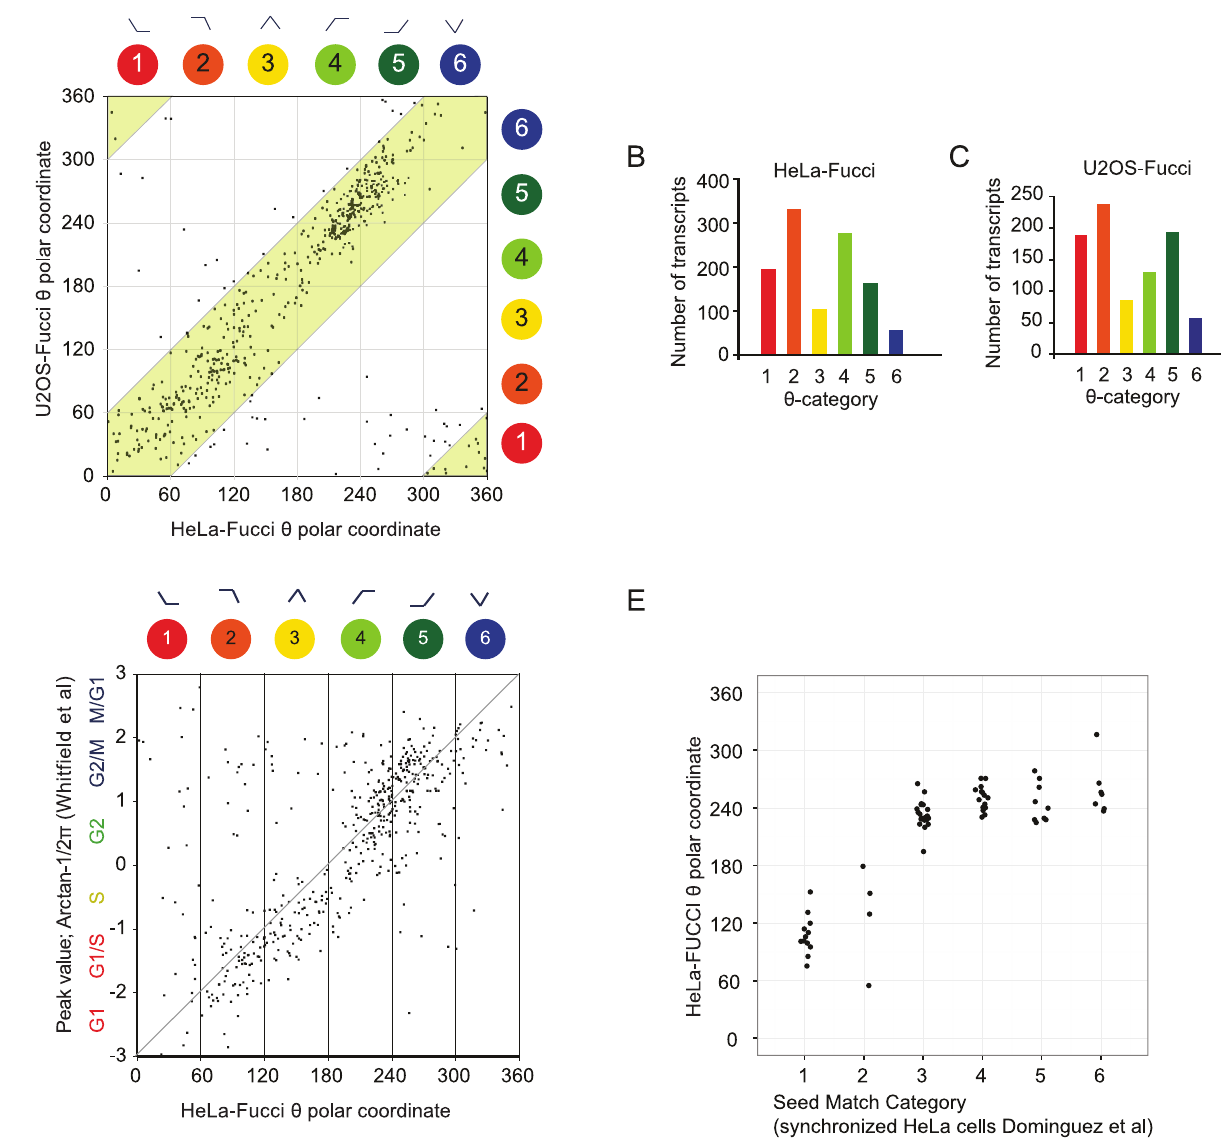
Fig 2. Comparisons of different cell cycle data sets show consistent expressionpatterns. (A) Comparativeanalysisof HeLa-Fucciand U2OS-Fucci cell cycle-dependent transcriptomes after plotting their respective θ -valuefor each shared transcript (stringencylevel: FDR (cid:20) 0.001). The green area denotesa correlationof less than 60 degreesin the θ -value.(B, C) Number of transcripts in each of the six TriComp θ -categories (FDR (cid:20) 0.001). (D) Plot of the θ -valuefor HeLa-Fucci transcripts versus the reportedphase peak value for each probe reportedby Whitfield et al .[19]. (E) Categorydistributionplots for the core set of 67 genes reportedby [18] versus the θ -valuefor genessignificantly oscillating(FDR (cid:20) 0.001) in HeLa-Fucci